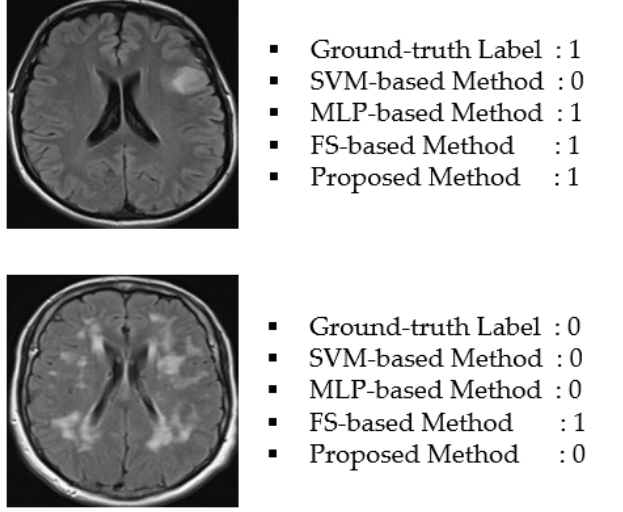
Figure 12. Example of enhancement cases using our proposed method (Label 0 indicates the non- tumor image; Label 1 indicates the tumor image).